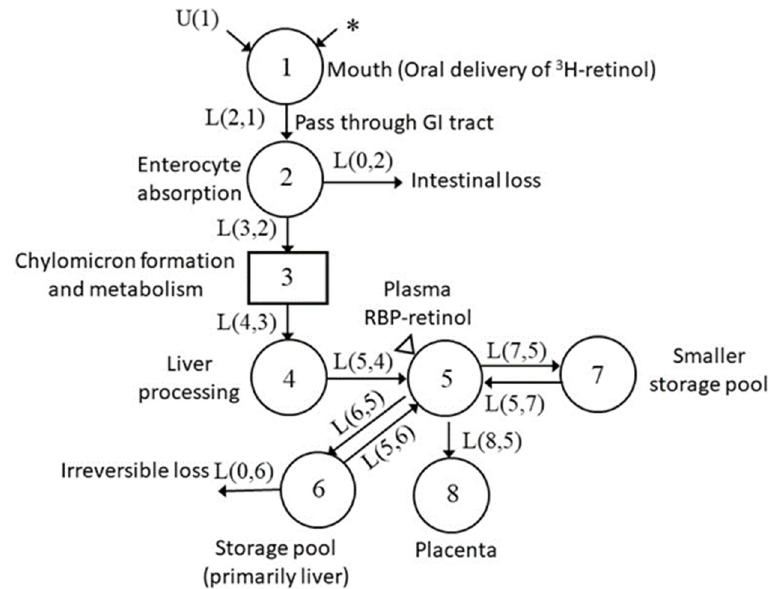
Figure 5. Proposed model for VA tracer kinetics in pregnant–lactating rats in early pregnancy. Each